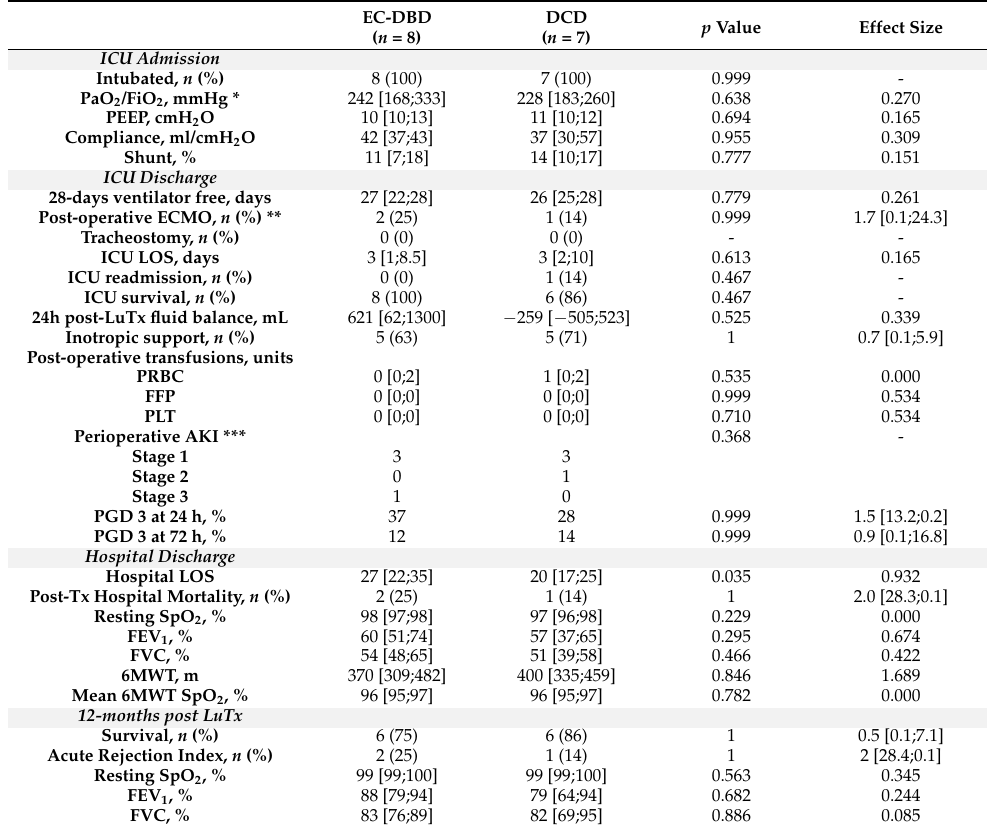
Table 5. Recipient